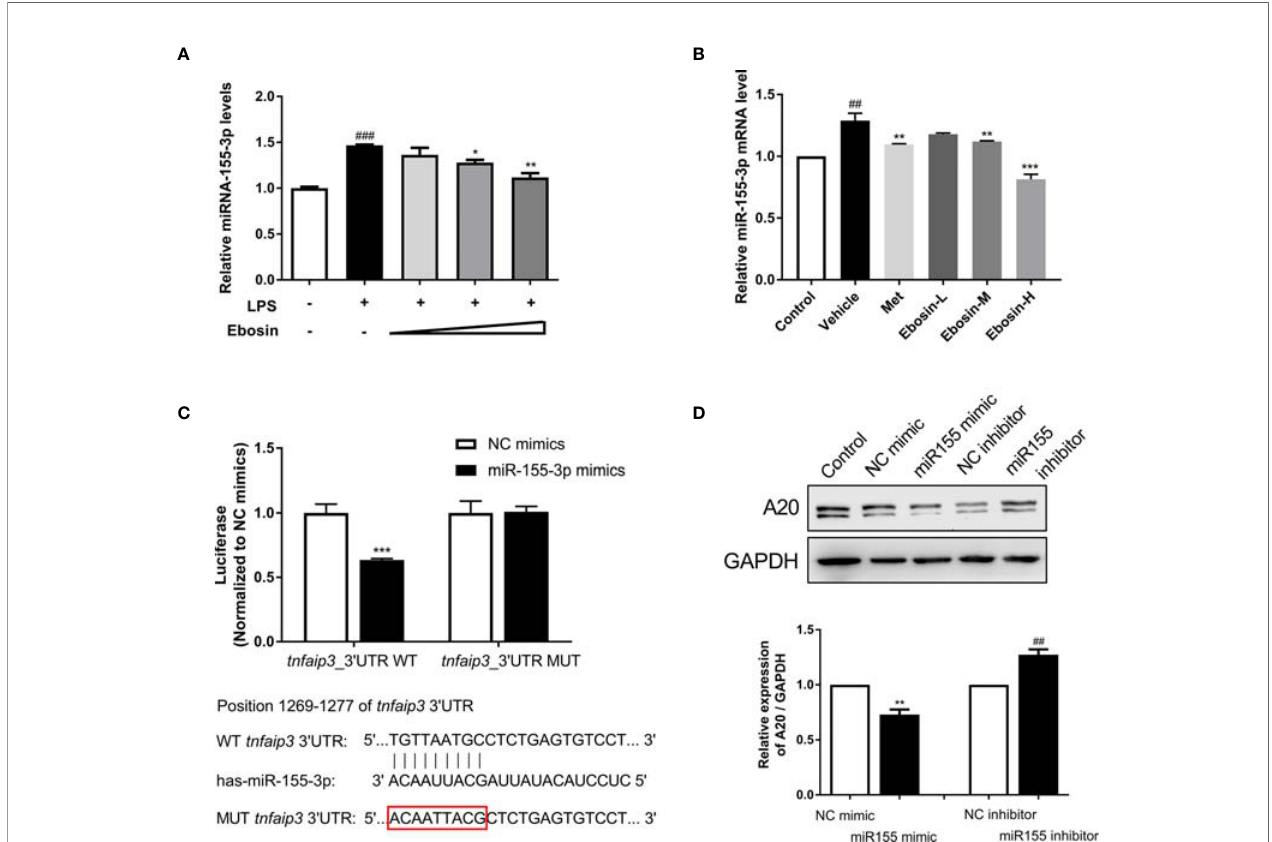
FIGURE 6 | Effect of Ebosin on miRNA-155 targeting tnfaip3 . (A) RT-PCR analyses of miR-155 in LPS-induced HaCaT cells without or with Ebosin. (B) RT-PCR analyses of miR-155 in skin of IMQ-induced psoriasis-like mice without or with MTX and Ebosin. (C) Schematic view of miR-155 putative targeting site in the wild type (WT) and mutant (Mut) 3 ′ -UTR of tnfaip3 , and luciferase reporter analysis to con fi rm the binding between miR-155 and tnfaip3 . (D) The protein expression level of A20 in HaCaT cells introducing miR-155 mimic or inhibitor. All data were presented as mean ± SD; n = 3. ## P < 0.01, ### P < 0.001 vs. control; * P < 0.05, **P < 0.01, ***P < 0.001 vs. LPS or IMQ-induced vehicle